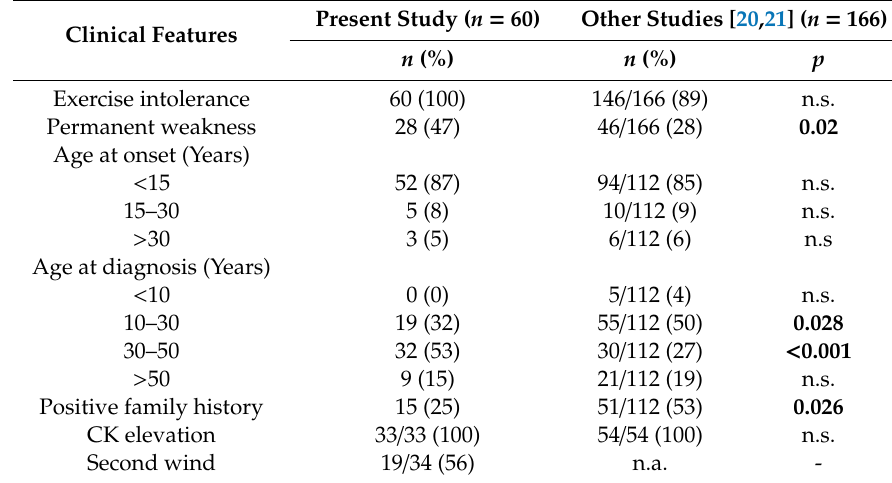
Table 2. Clinical features of McArdle patients in present cohort compared to meta-analysis of previous studies.